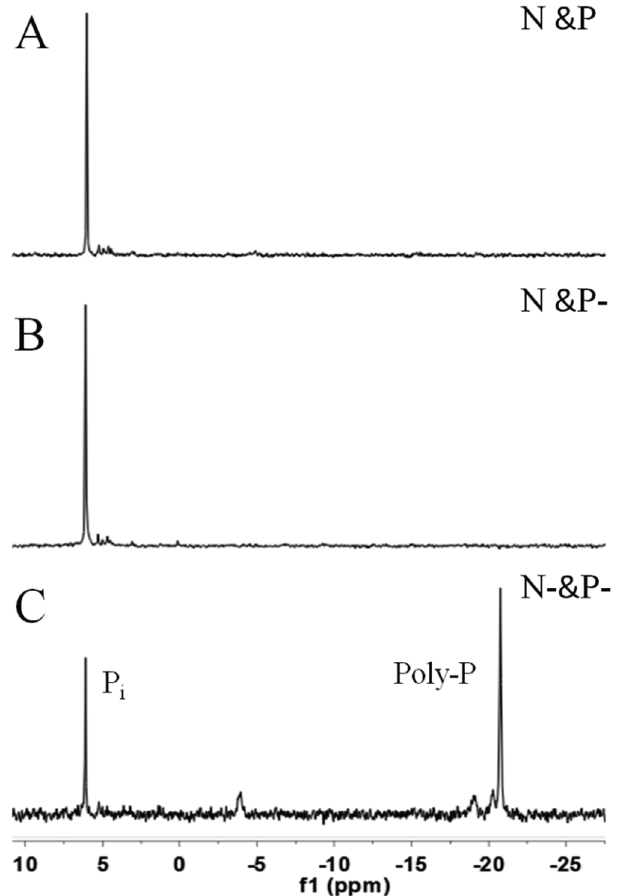
Figure 5. The 31 P NMR spectra of C. vulgaris cultured in N and P ( A ); N and P − ( B ); and N − and P − ( C ) media for three days. P i ; inorganic phosphate, Poly-P;